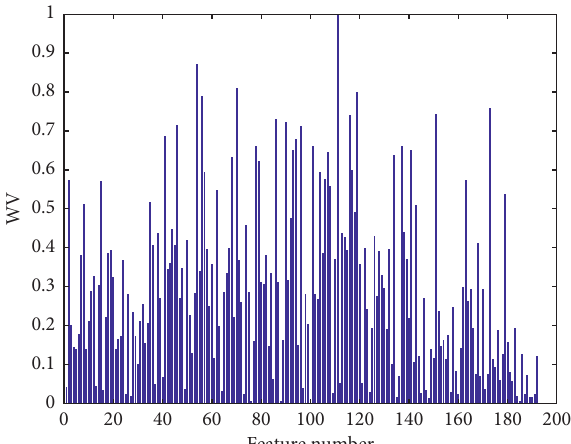
Figure 3: The WV of 192 statistical features of the training samples.